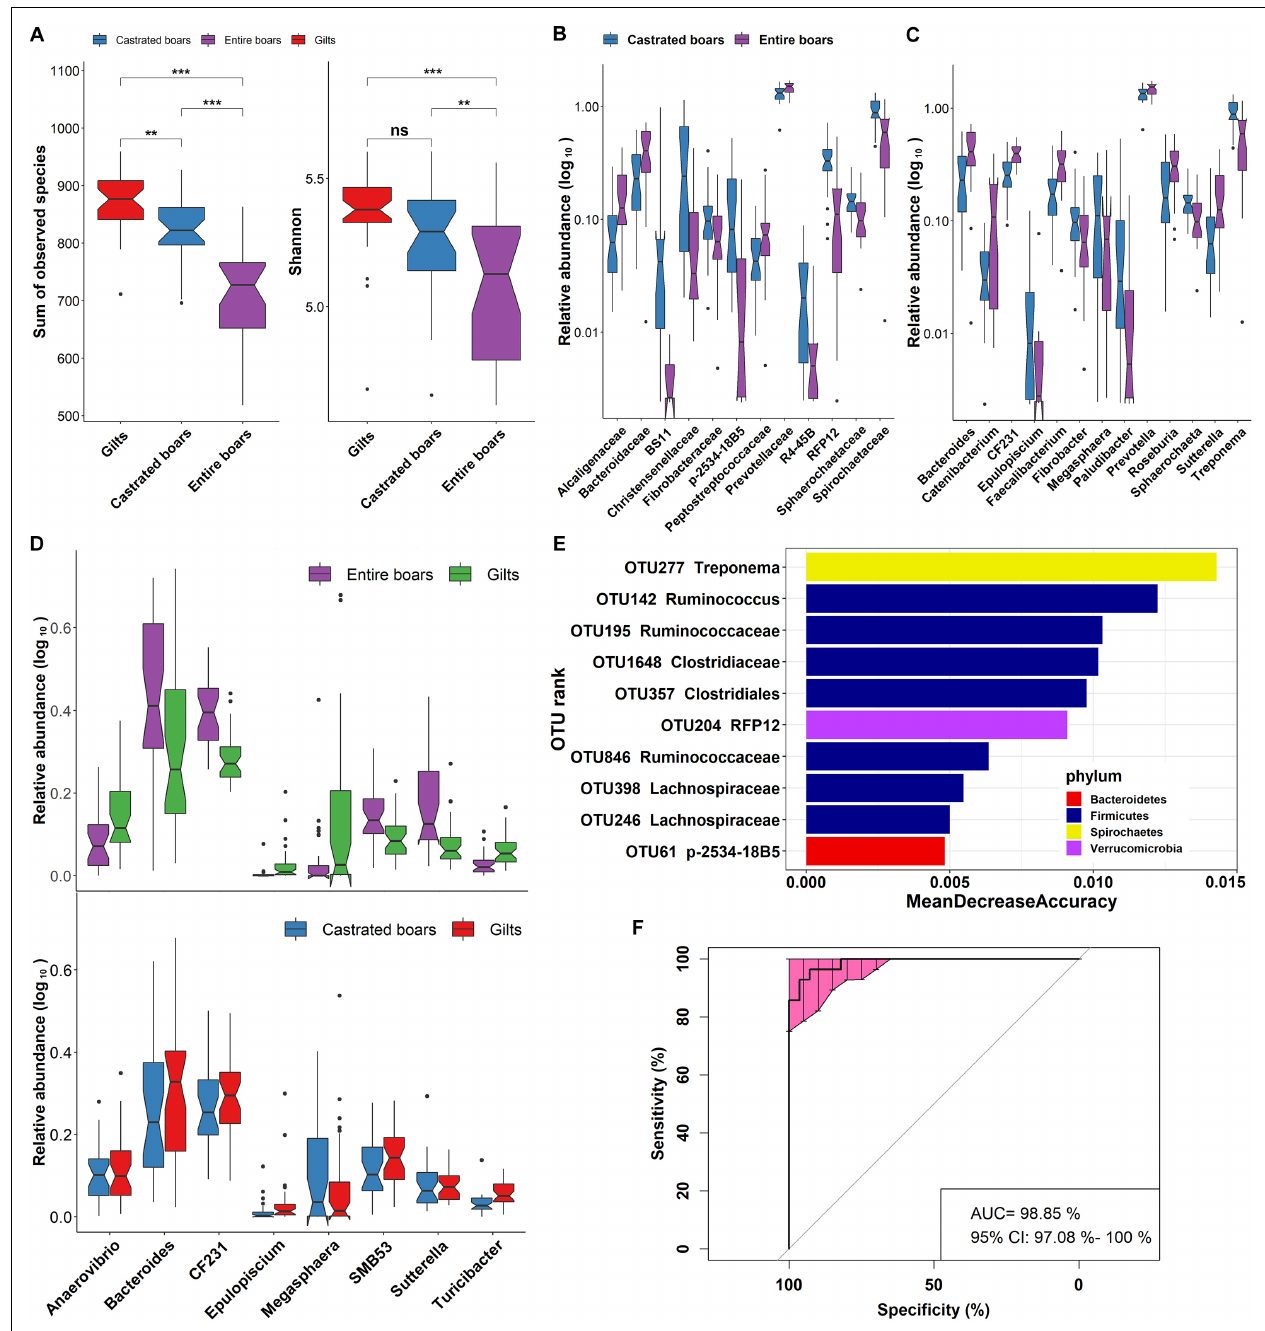
FIGURE 3 | Significant shifts of gut microbial compositions before and after castration. (A) Comparison of feces microbial compositions among castrated boars, entire boars, and gilts based on the index of observed species and Shannon in F 6 pigs. Violin plots show that the richness and diversity of fecal microbiota in castrated boars were closer to gilts. (B,C) The differential bacterial taxa before and after castration at the family and genus level. (D) The sex-biased bacterial genera between entire boars and gilt counterparts were no longer the distinct bacterial genera between castrated boars and gilts. (E) The top 10 biomarkers of OTUs that could discriminate the samples from entire or castrated boars by Random Forest model. Biomarker OTUs were ranked in descending order of importance to the accuracy of the model. (F) Receiver operating curve (ROC) for entire and castrated boars. The AUC value was 98.85% with 95% CI of 97.08–100%.